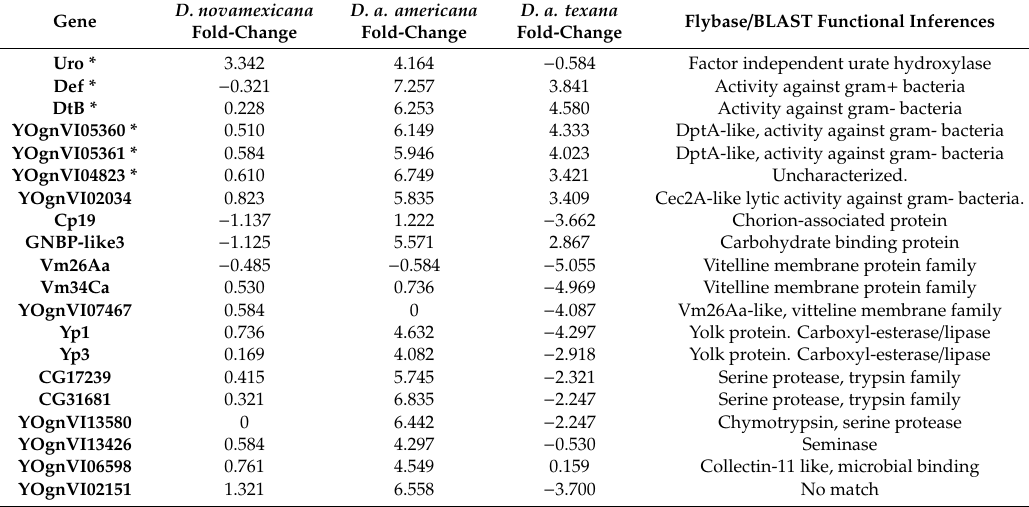
Table 2. Top 20 genes with highest between-species variance in plastic responses to desiccation stress in males, as measured by fold-change in expression between control and desiccation treatments. * Loci also found in top 20 genes for females (Table 3). The next 10 most plastic loci are listed in Supplement Table S1.